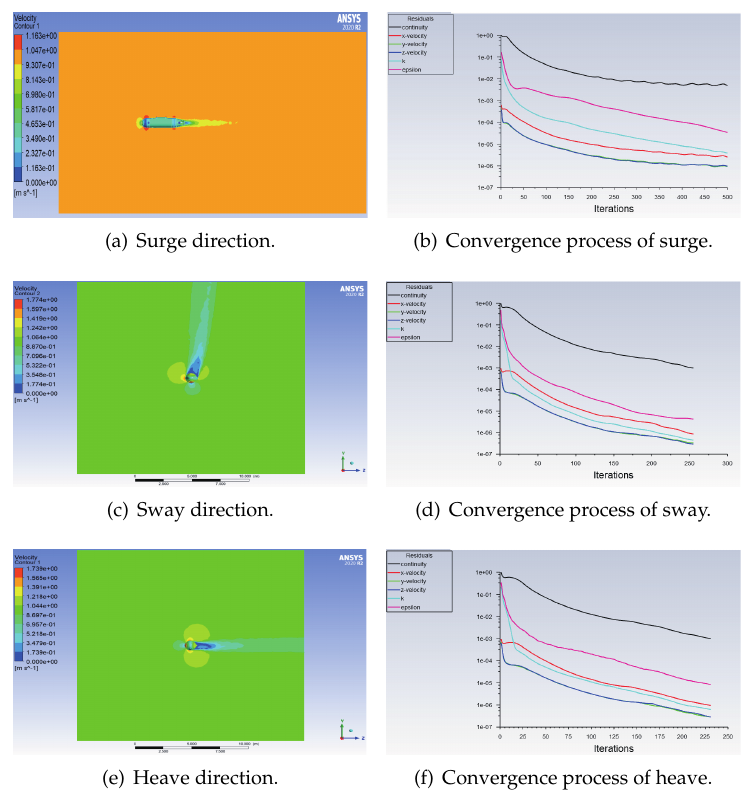
Figure 4. Velocity cloud diagram and convergence process of CFD